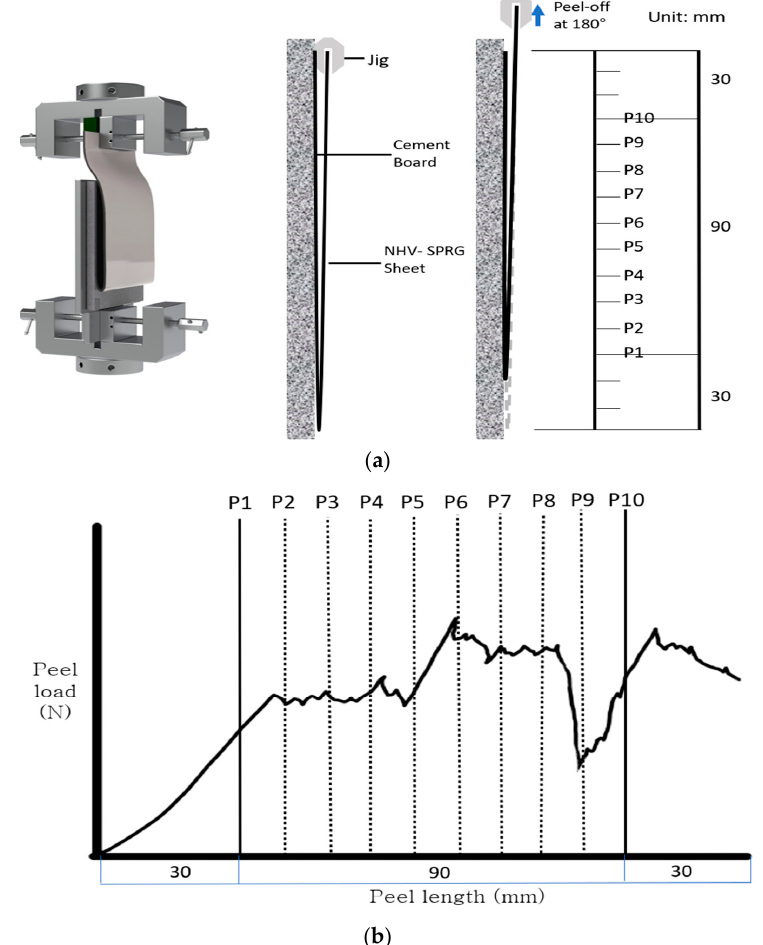
Figure 8. 180° peel-off test method and data graph example; ( a ) testing process illustrated, ( b ) data procurement example illustrated